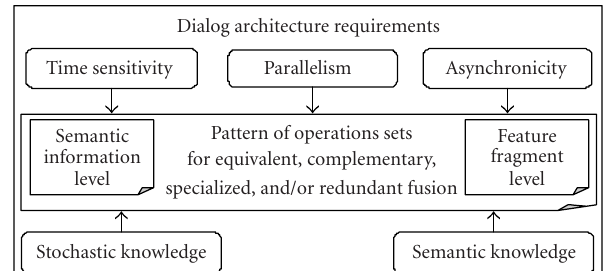
Figure 1: The main requirements for a multimodal dialog architec- ture ( → : used